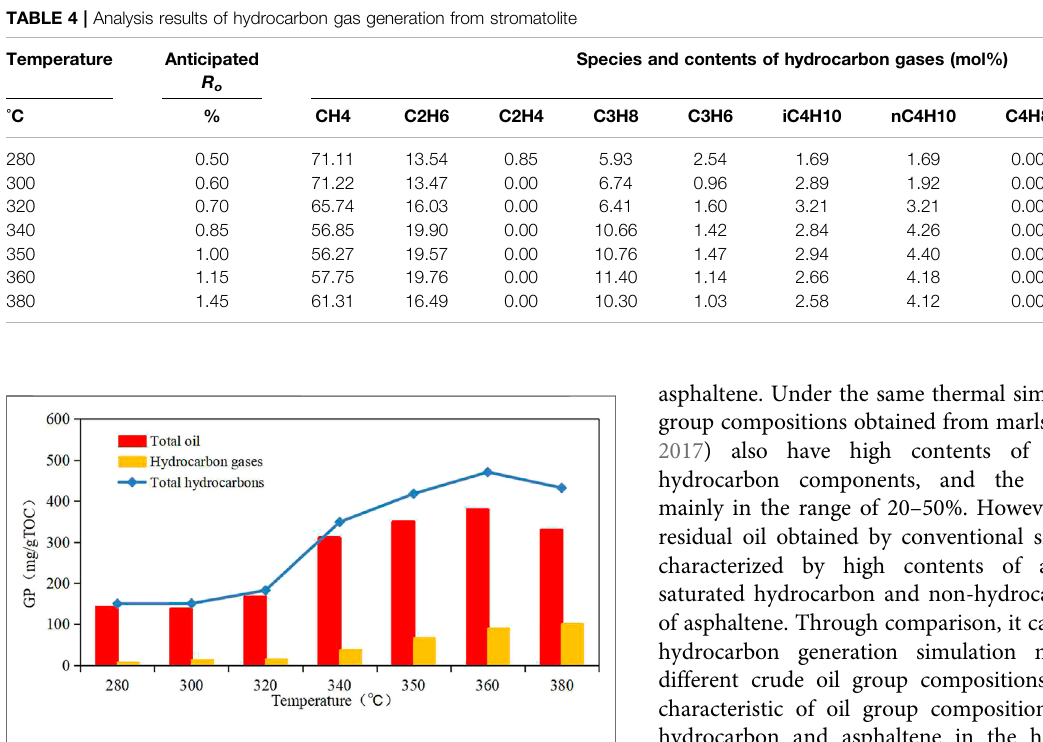
FIGURE 5 | Comparison of hydrocarbon gas and oil generation potential.